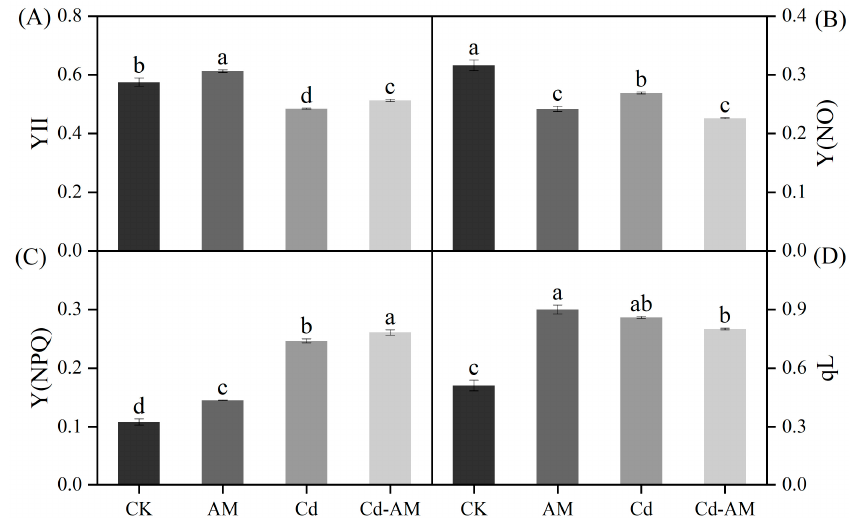
Figure 1. Response of M. truncatula leaf fluorescence parameters Y(II) ( A ), Y(NO) ( B ), Y(NPQ) ( C ), and qL ( D ) under different treatments. Values are expressed as means ±SE ( n = 3). Values followed by the same letter in the same column are not significantly different ( p < 0.05).